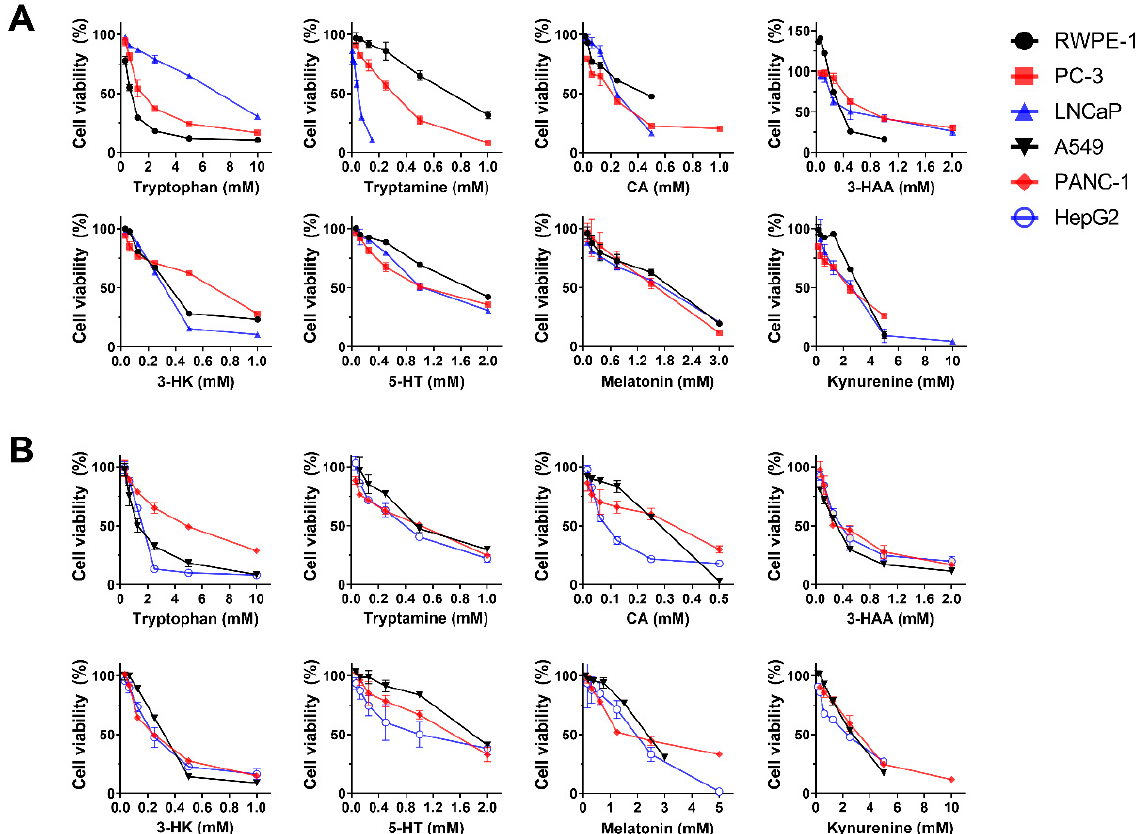
Figure 3. Cytotoxicities of major metabolites of the tryptophan pathway. MTT cell proliferation assays of various concentrations of tryptophan, tryptamine, CA, 3-HAA, 3-HK, 5-HT, melatonin, and kynurenine in ( A ) PC-3, LNCaP, and RWPE-1, and ( B ) A549, PANC-1 and HepG2